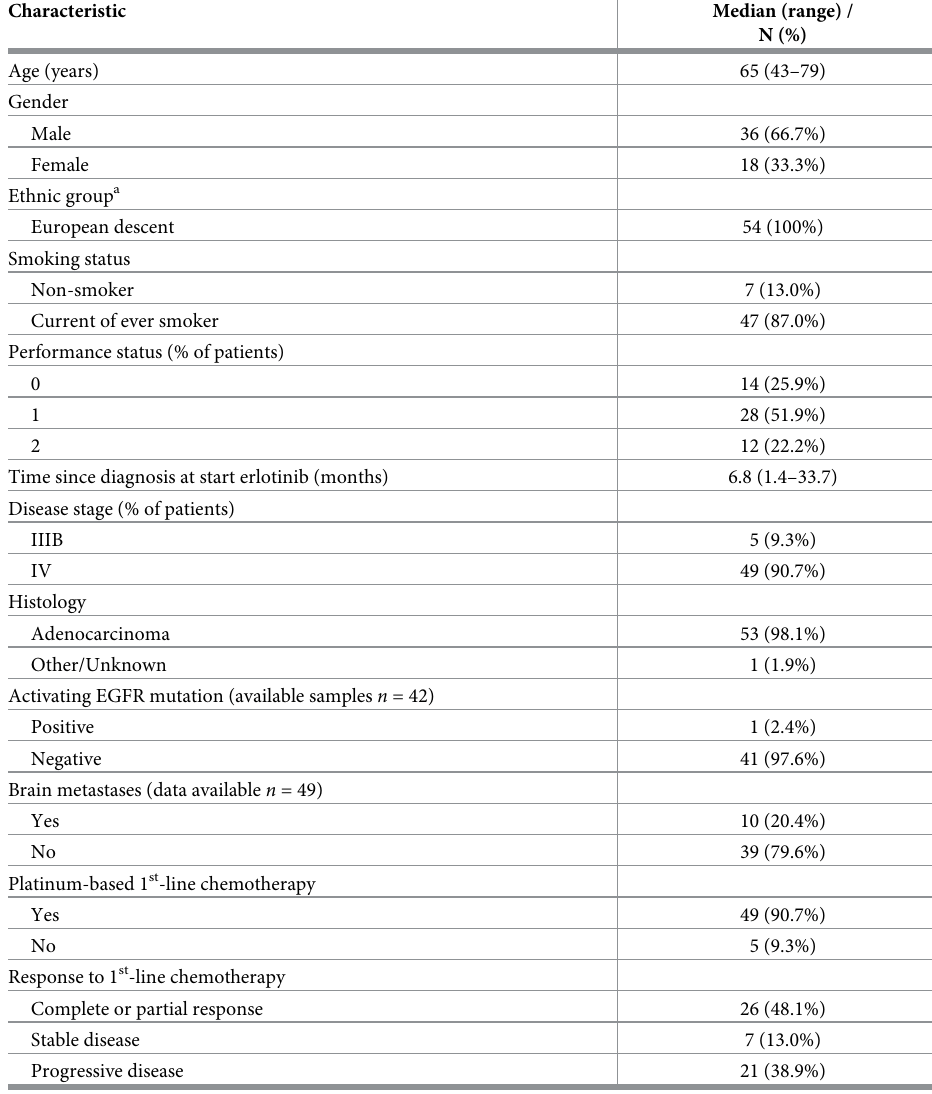
Table 1. Baseline characteristics of the patients in the per-protocol population ( n =